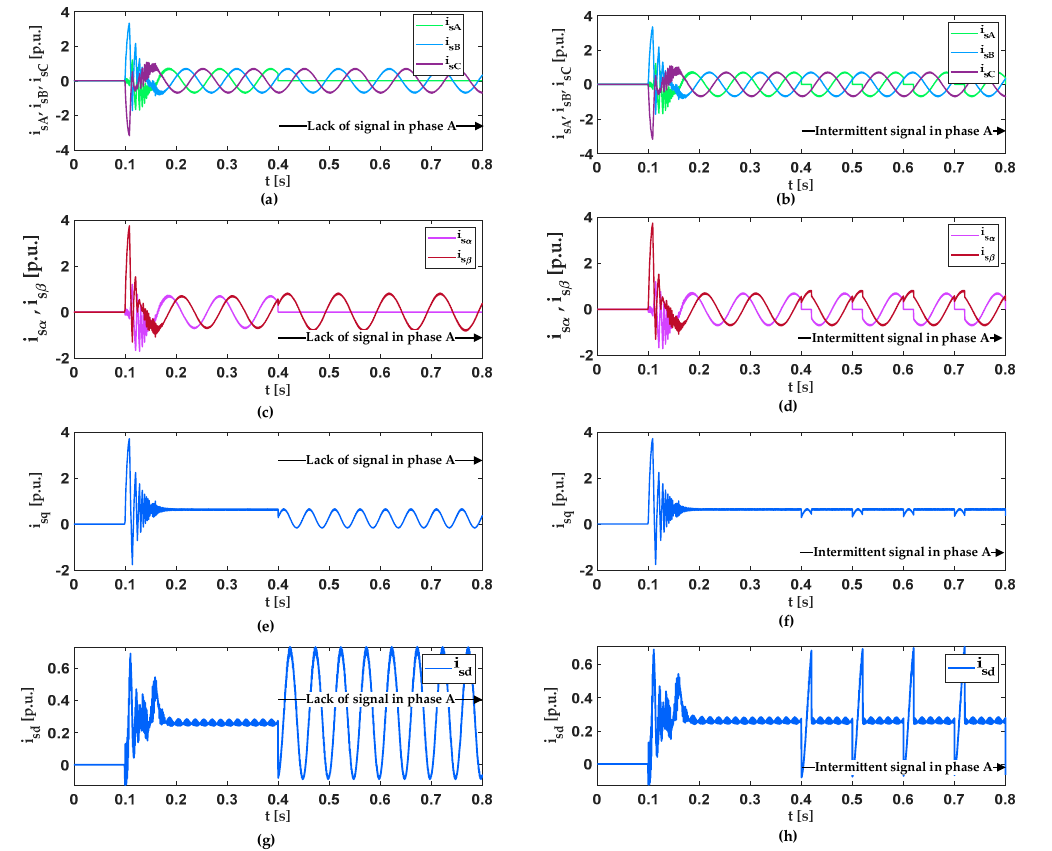
Figure 4. Influence of lack of signal ( a , c , e , g ) and intermittent signal ( b , d , f , h ) on phase currents i sA , i sB , i sC ( a , b ), stator current components (cid:1861) (cid:3046)(cid:3080) , (cid:1861) (cid:3046)(cid:3081) ( c , d ), currents (cid:1861) (cid:3046)(cid:3031) , (cid:1861) (cid:3046)(cid:3044) ( e , f , g , h ) in the scalar control structure.